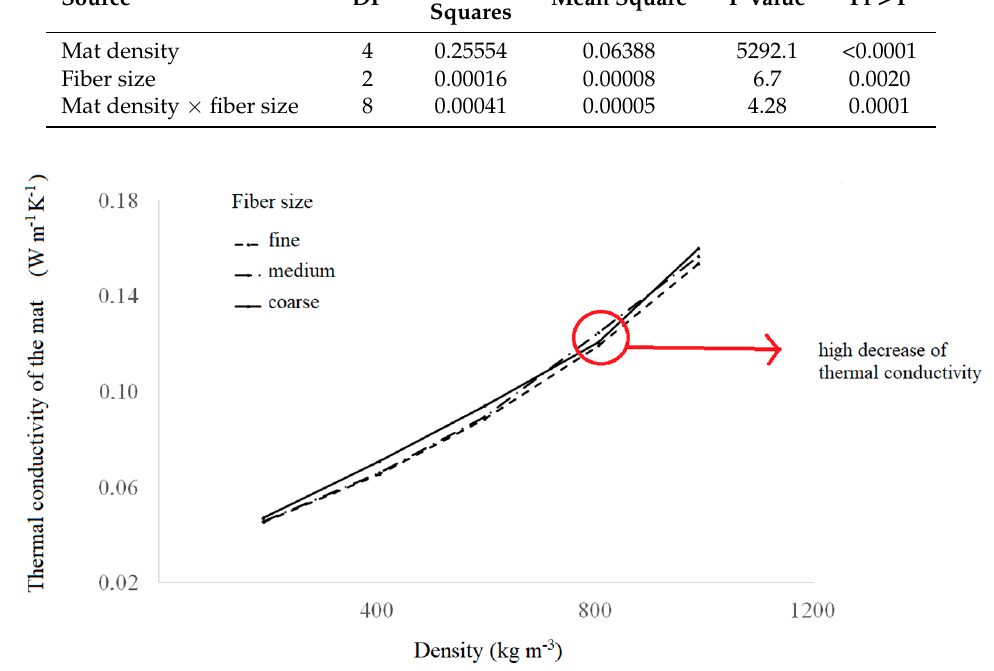
Figure 11. Interaction of thermal conductivity of the mat versus density at different fiber sizes.